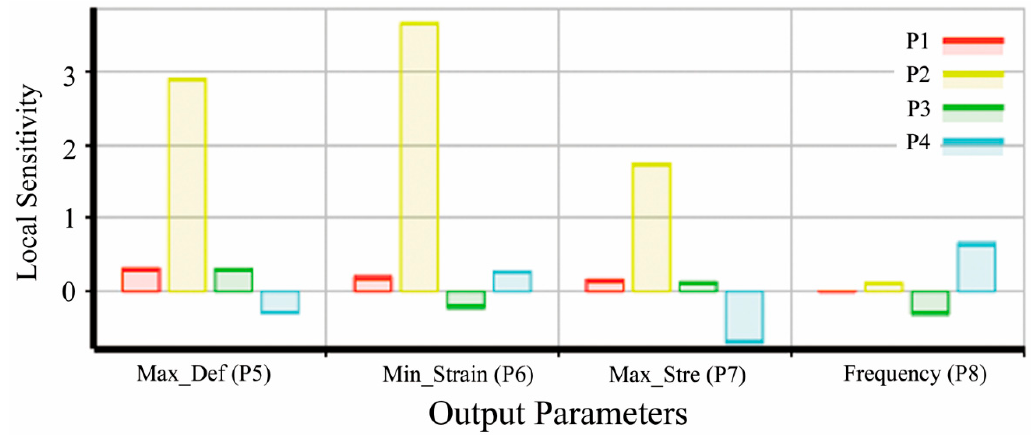
Figure 6. Sensitivity of the input parameters with respect to each output variables.